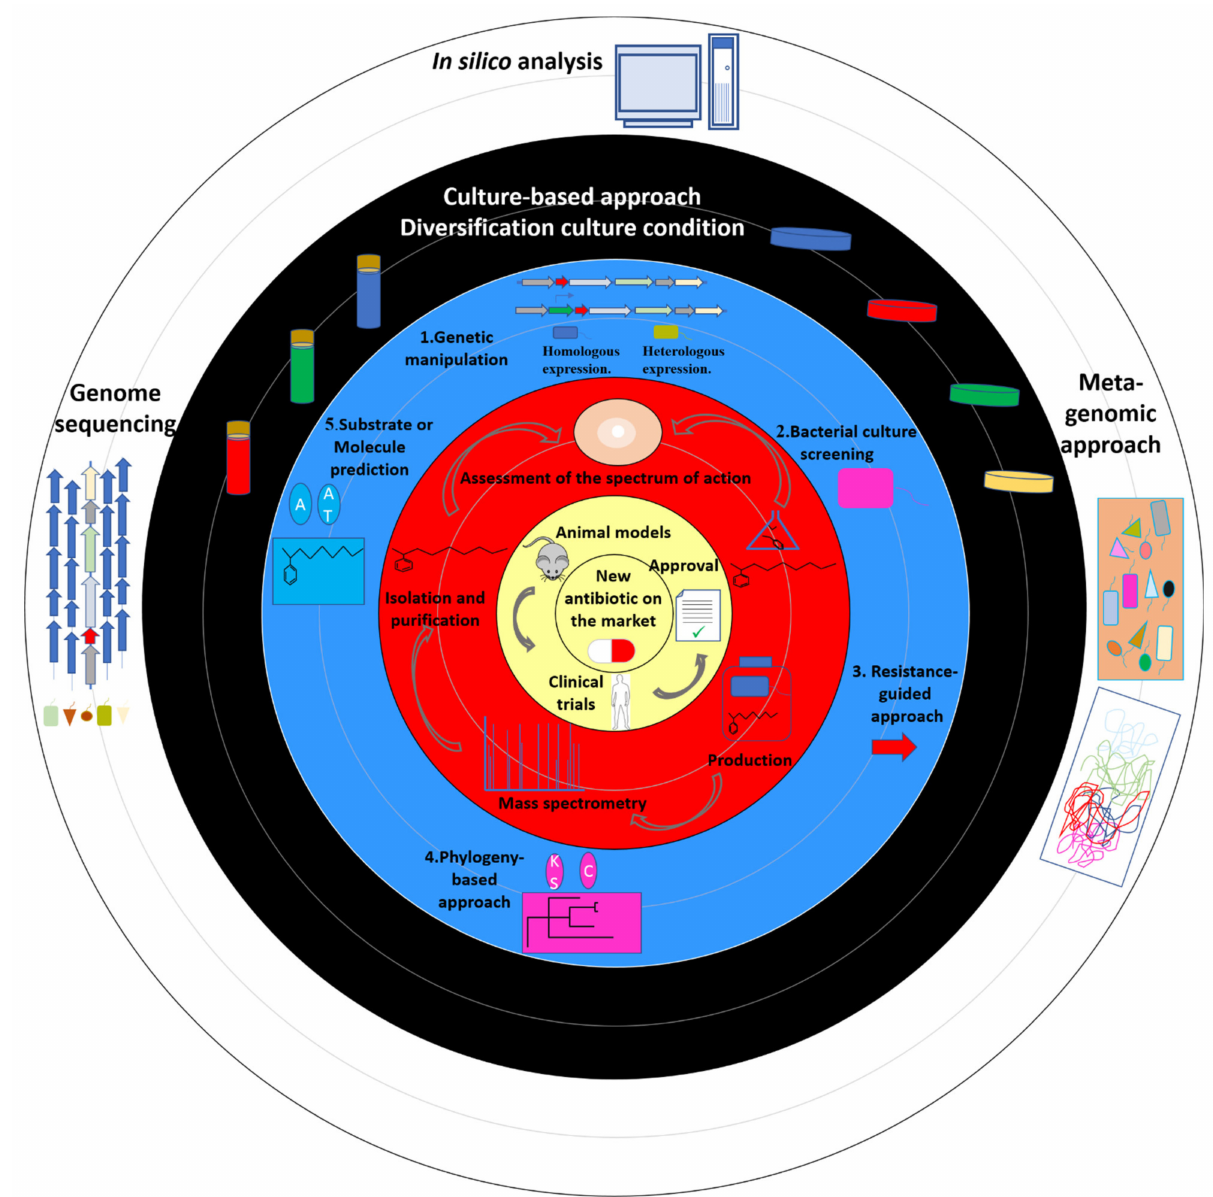
Figure 2. From materials and methods to market: schematic representation of materials and different in silico/in vitro strategies to identify new compounds with antimicrobial activity. The circles represent the different stages of the